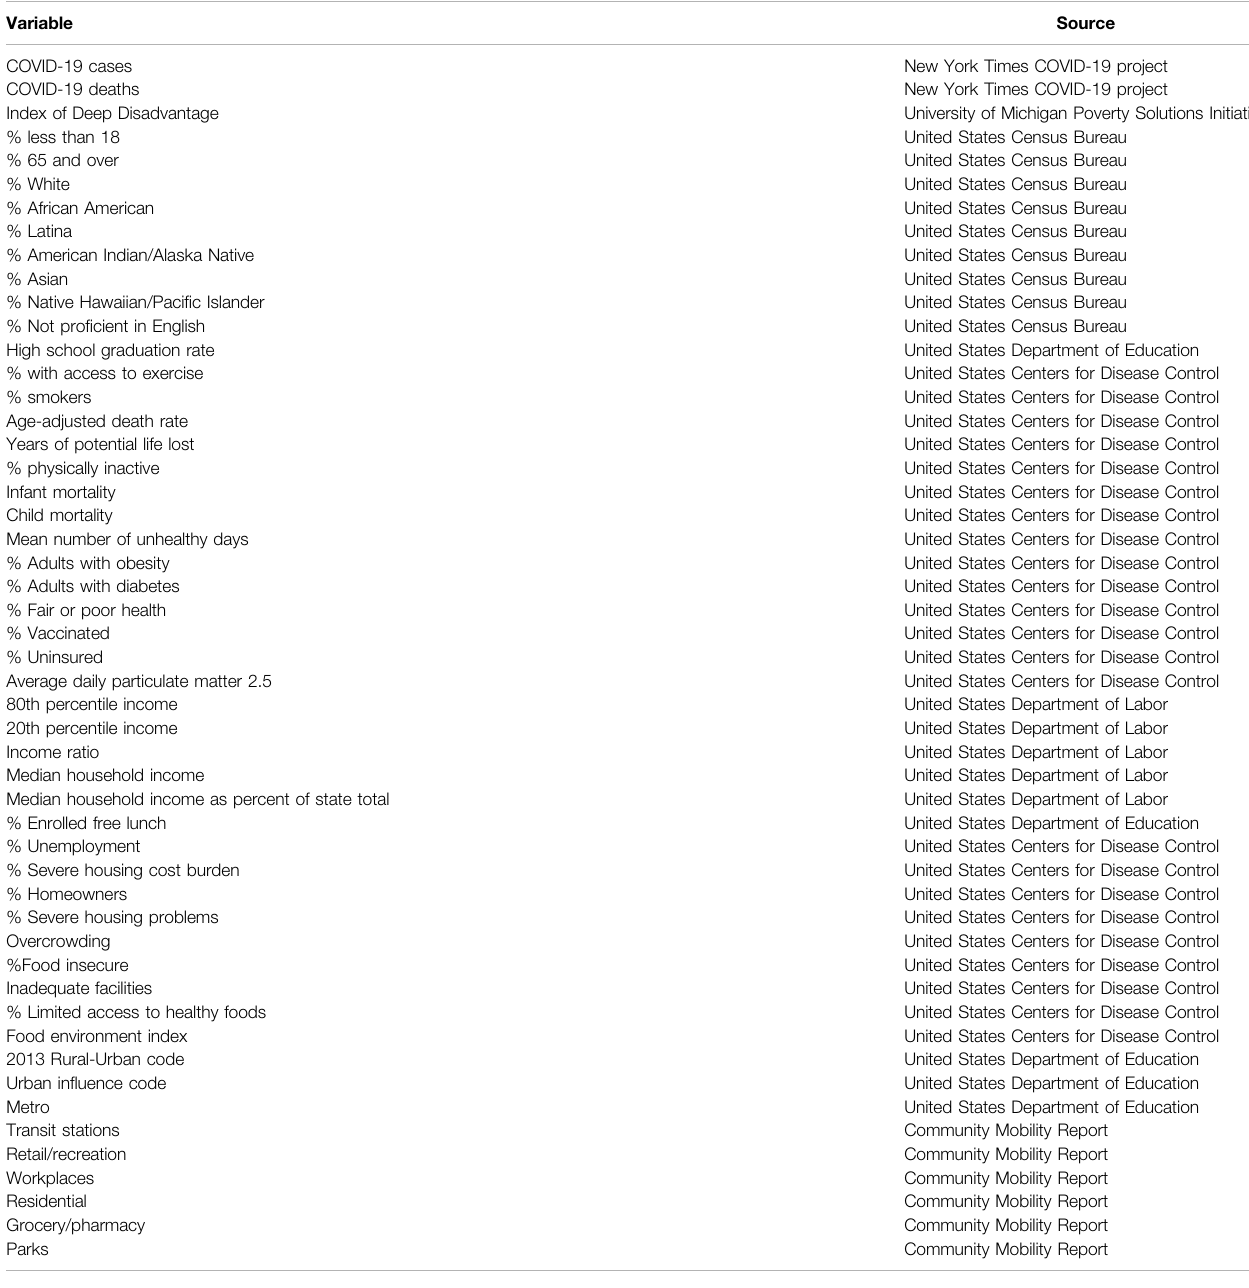
TABLE 1 | Variables used in the